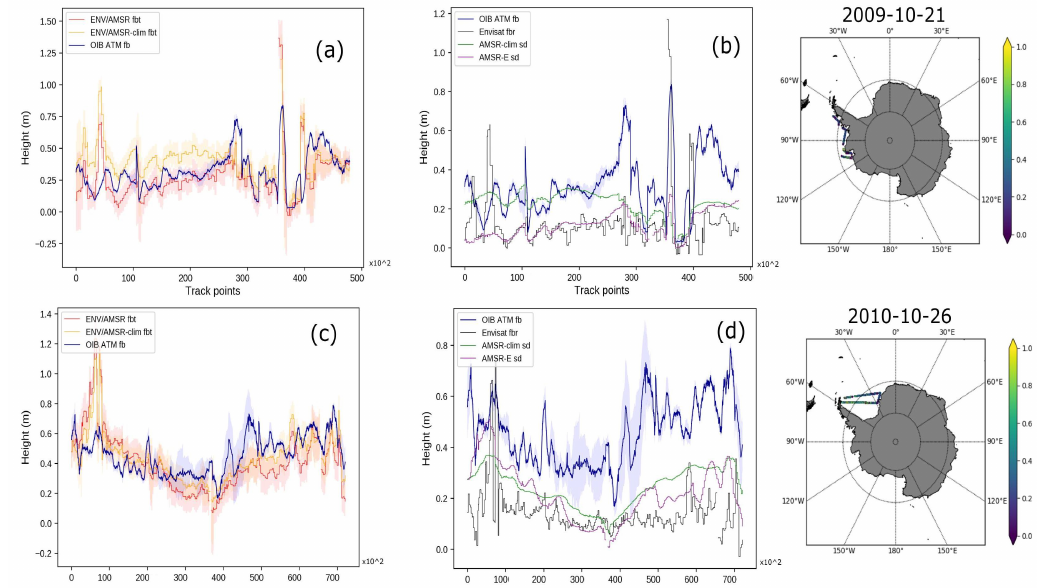
Figure 6. ( a ) Along-track comparison with the OIB ATM total freeboards of the 21 October 2009 (first line) and 30 October 2009 (second line) missions. The figures ( a , c ) compare with the calibrated Envisat total freeboards computed from AMSR-E (ENV-AMSRE) and AMSR-clim (ENV-AMSRclim). The figures ( b , d ) compare with the 2 AMSR snow depth solutions and the calibrated Envisat radar freeboards. The shaded zone refers to the uncertainty of the products. The maps on the third line indicate the geographical location of the OIB